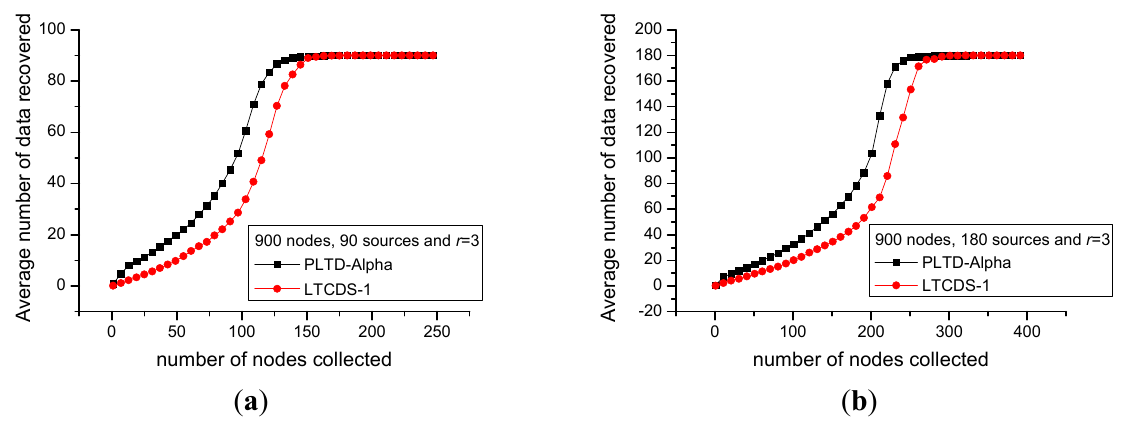
Figure 11. Data recovery performance in large scale WSN system. ( a ) n = 900, k = 90, ( b ) n = 900, k =